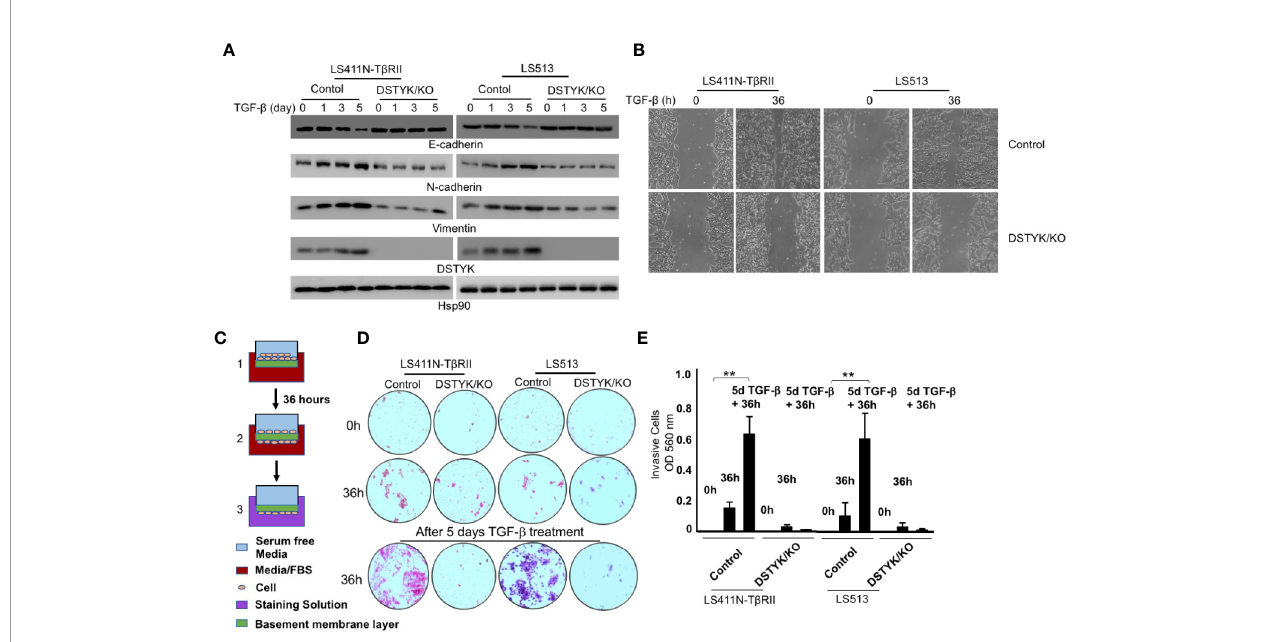
FIGURE 3 | DSTYK is required for TGF- b -induced EMT in CRC cells. (A) Immunoblotting analyses were employed to compare the protein levels of DSTYK and the EMT markers E-cadherin, N-cadherin and vimentin between control cells and DSTYK/KO cells during a 5-day TGF- b treatment timecourse. Hsp90 was used as loading control. (B) Representative images of a wound healing assay with LS411N-T b RII cells and LS513 cells. (C) Schematic of the principle of a cell invasion assay. (D) Top: The cells on the basement membrane before invasion at 0h. Middle: The cells migrating to the bottom of membrane after 36h invasion. Bottom: The cells on the bottom of membrane after 36h invasion from 5 days of TGF- b treatment. Representative images of the lower chamber of the trans-well invasion assay in different treatment groups are shown for LS411N-T b RII or LS513 cells. (E) The quanti fi cation of cell invasion assays in (D) . All the experiments were repeated at least three times. **P < 0.01. Data are shown as mean ± SD, n=3 independent